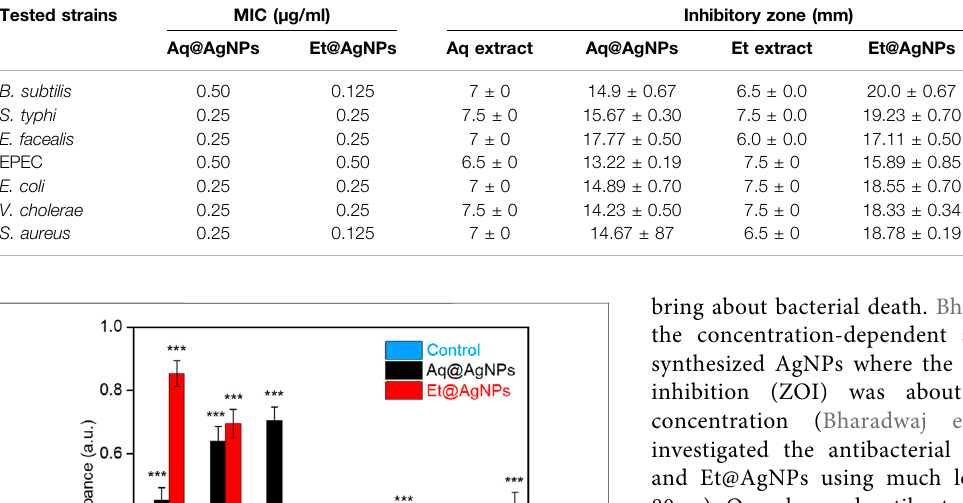
TABLE 1 | Minimum inhibitory concentration (MIC) as well as the zone of inhibition (ZOI) of the as-synthesized bAgNPs against different bacteria. Tested strains